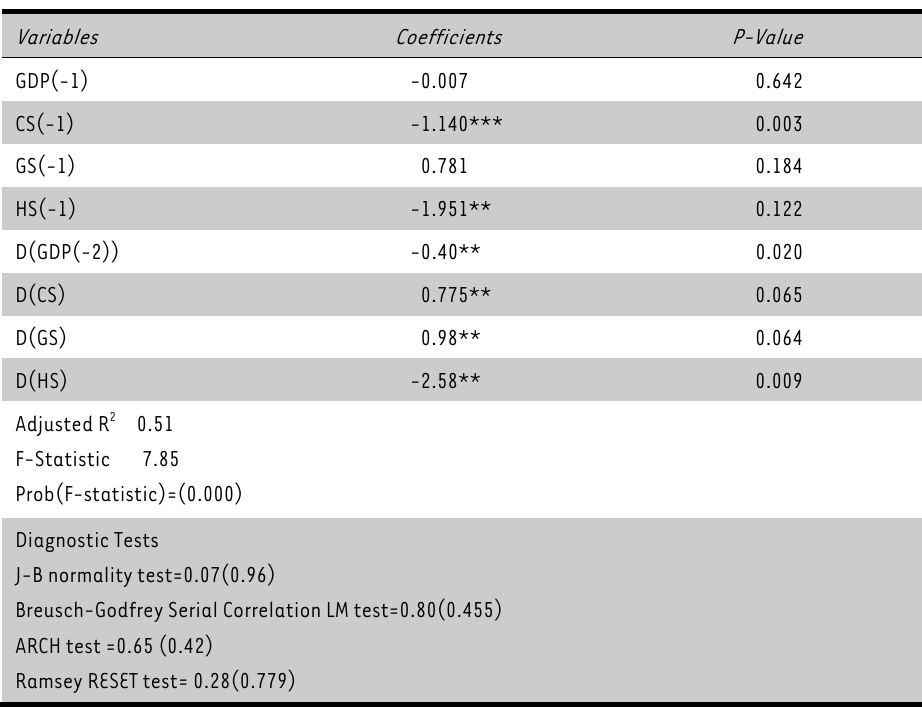
TABLE 2: Estimated ARDL model of equation 1